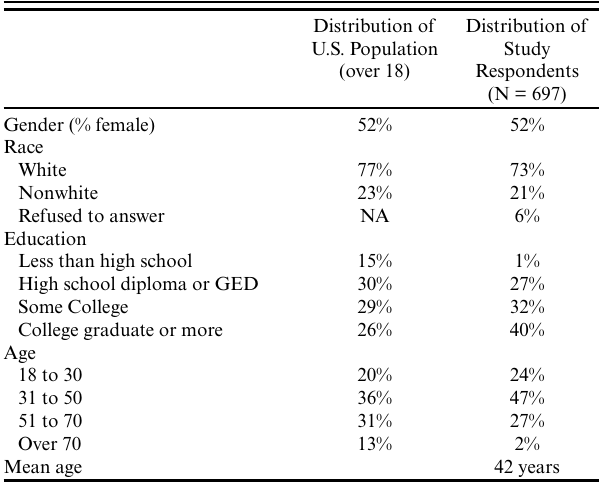
Table 2 . Characteristics of respondents participating in survey 1. Sample derived from web-based panel provided by Decision Research. Members were as closely matched to U.S. census data as reasonably possible resulting in total sample of n = 697 with higher than average proportion of college graduates, and younger than average U.S.